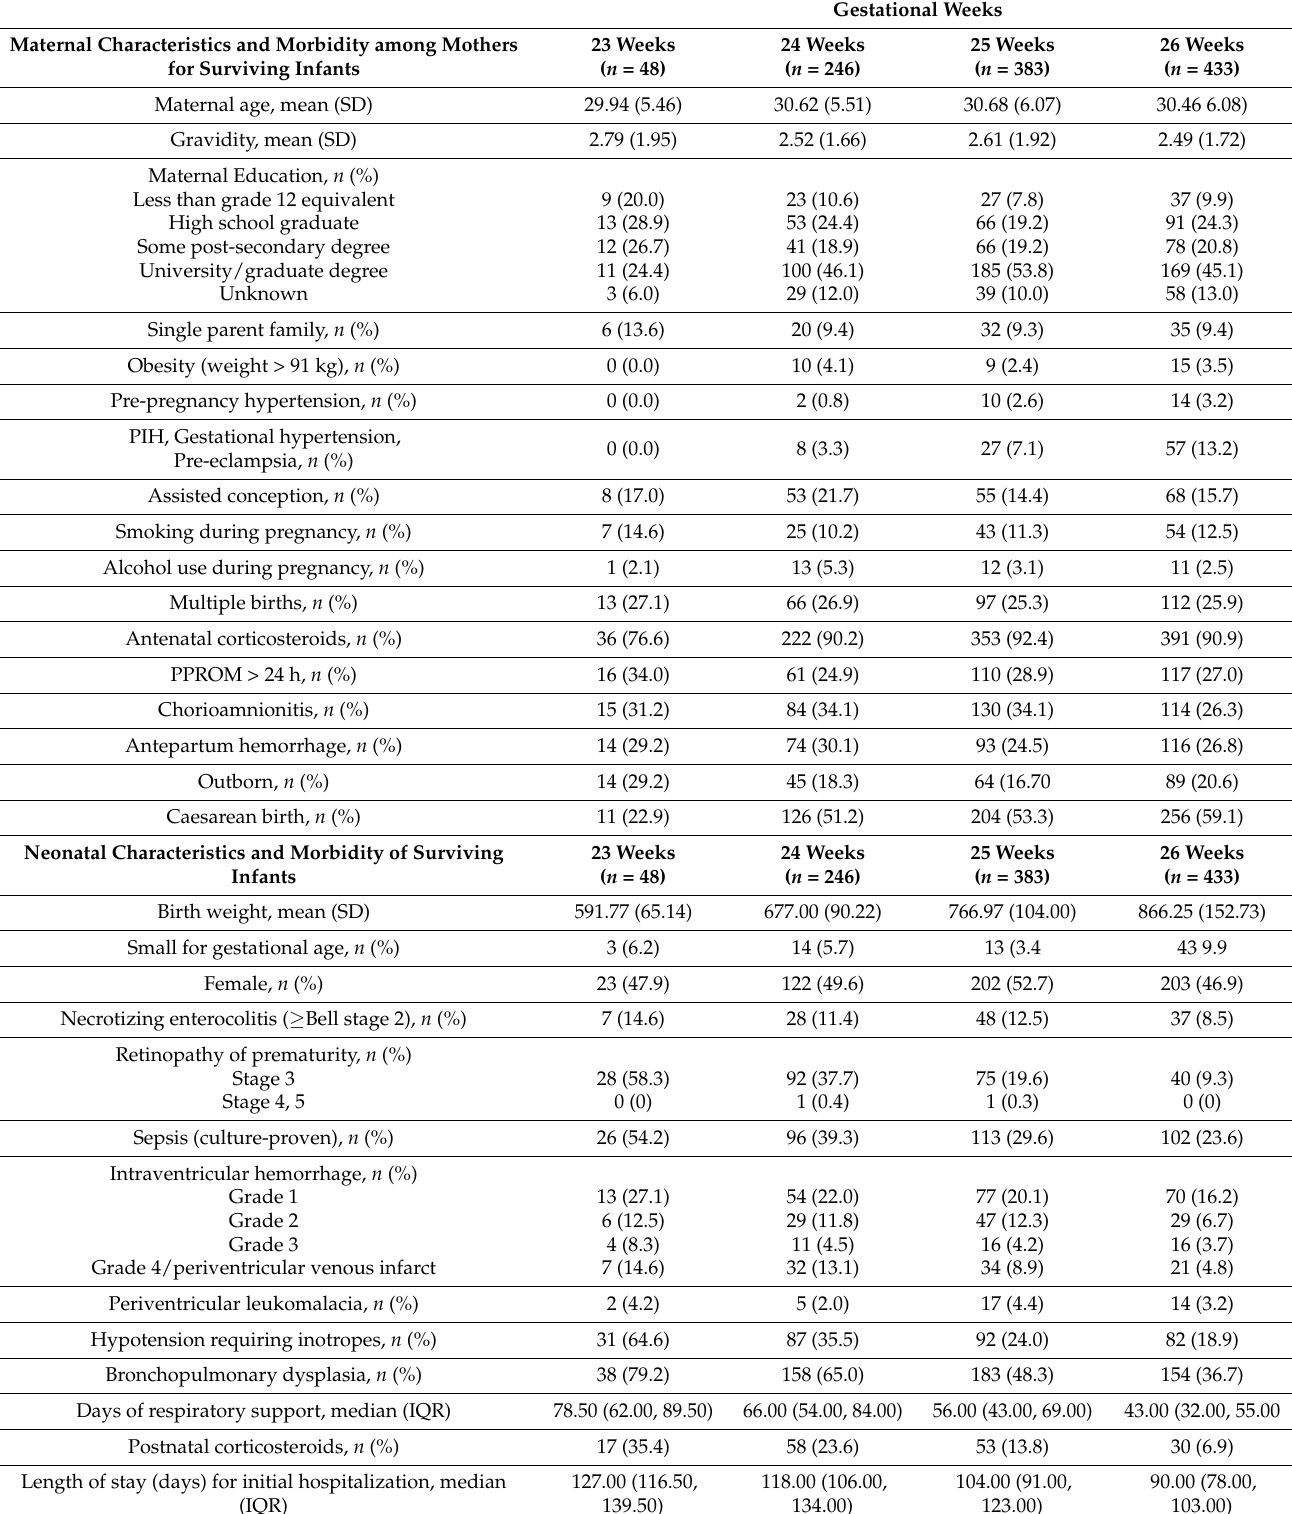
Table 2. Characteristics (maternal, neonatal) among all survivors (followed and not